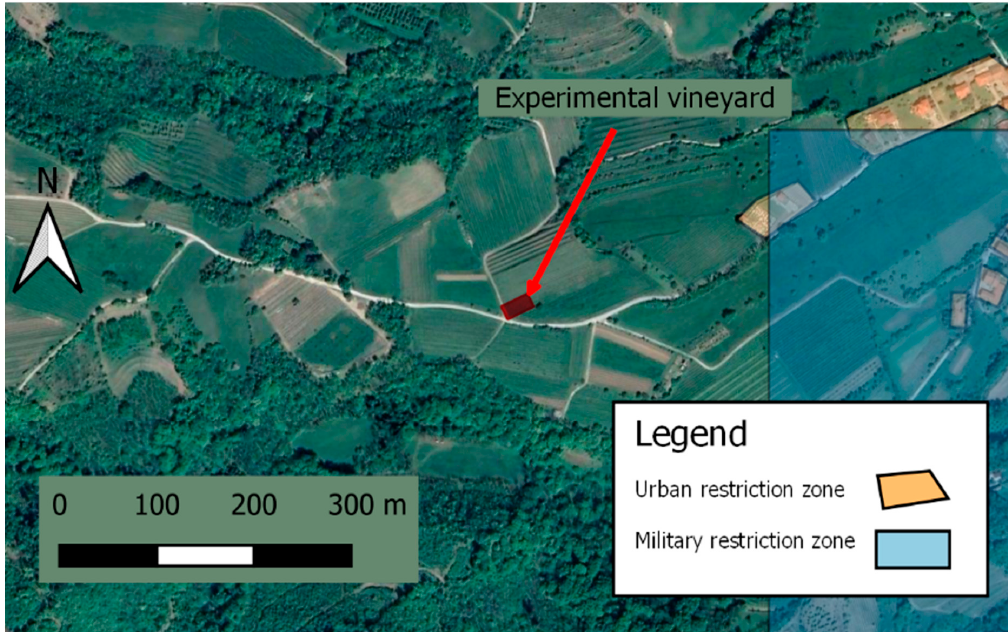
Figure 1. Location of the surveying part of the vineyard (red) and UAS flight restriction zones (military, blue and urban, yellow).